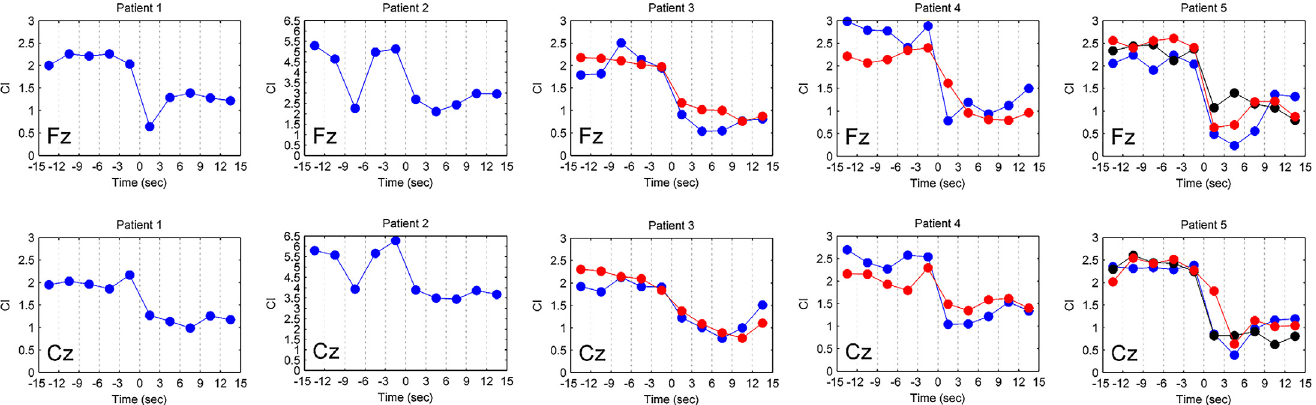
Fig 5. The variations of complexity index (CI) in different time period for five patients. Variations of CI at channels Fz and Cz in different time periods for five patients showed consistent CI changes in different seizures during the ictal states for the same patient. In contrast, the CI changes in different patients were not consistent. The different colors represented different seizure episodes in the same